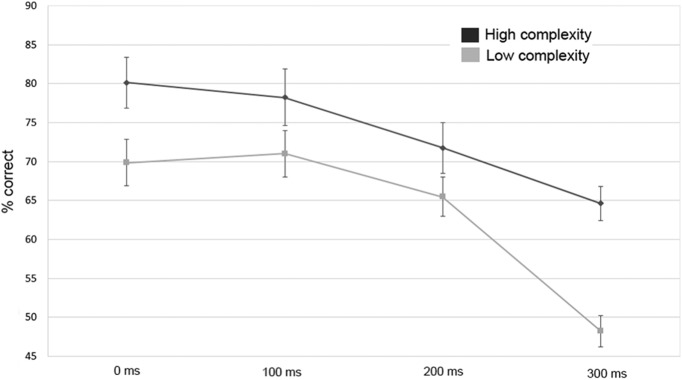
Accuracy (±1 SEM) for matching performance in the psychophysical experiment, separately for each level of the complexity (dark = for high complexity, light = low complexity) and asynchrony manipulations (0, 100, 200, and 300 ms offsets).